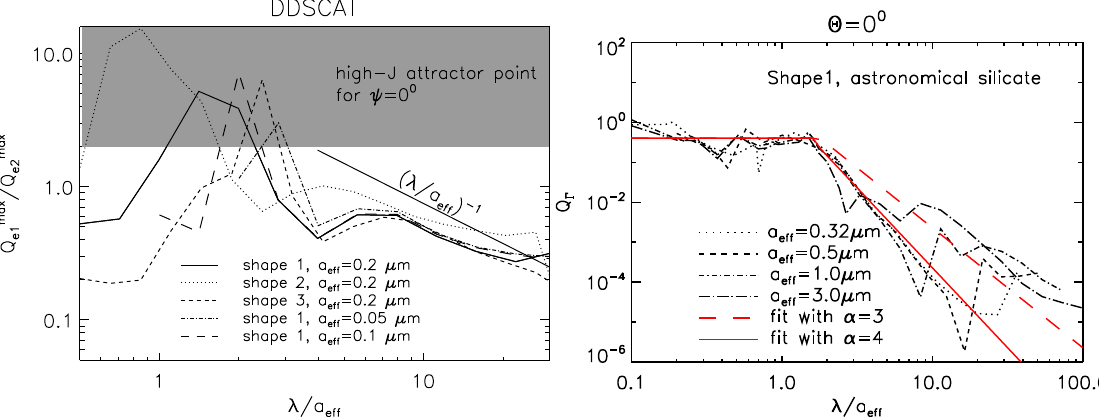
Figure 2. Radiative torques computed for the different grain sizes and shapes using DDSCAT from Lazarian and Hoang [29]. Left and right panels show the ratio of maximum torque components and RAT magnitude as function of λ / a eff . Astronomical silicate is considered. Power-law fits to the computed results are shown in red